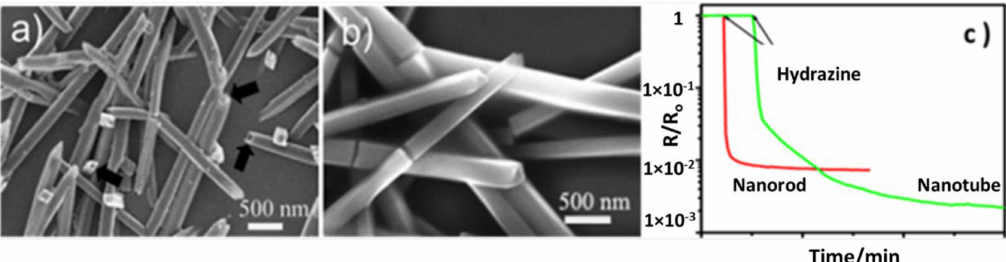
Figure 3. SEM images of ( a ) nanotubes and ( b ) nanorods of PDI-I. ( c ) Resistance modulation ( R / R o ) vs. time ( t ) curve measured on a single nanotube and nanorod hydrazine vapor. Adapted with permission